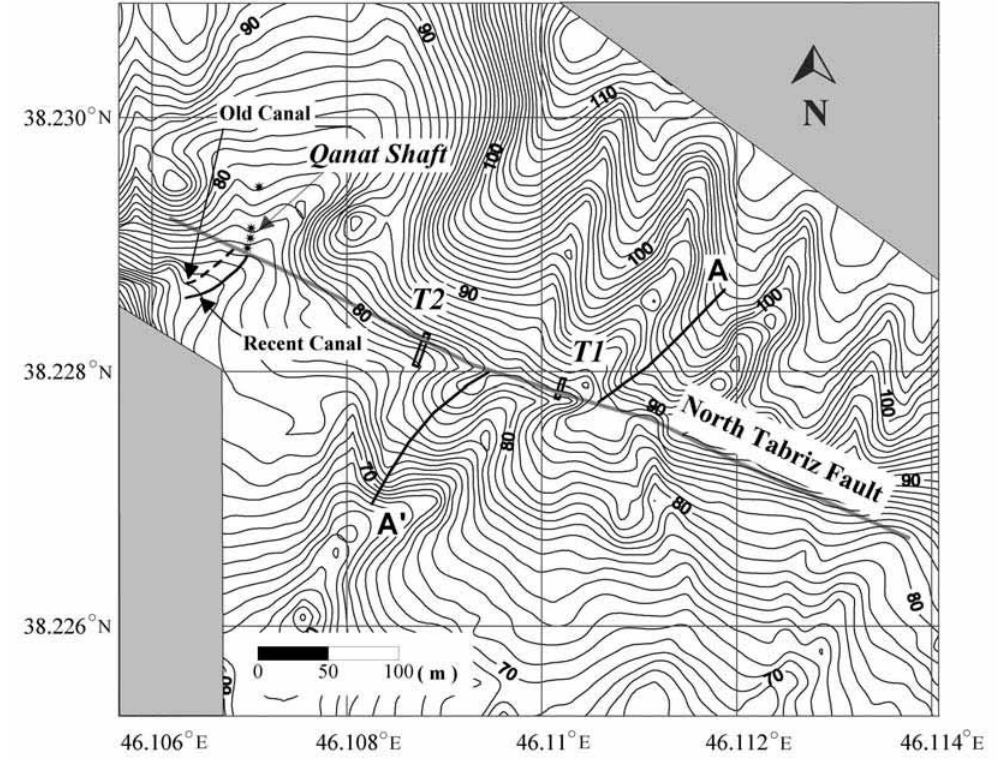
Fig. 6. Large scale topography map (1 m contour line) of the study area and location of trenches (T1 and T2) based on 1075 measured points using Total Station equipment. Displacement of Qanat shaft can be seen on either side of the fault trace. A-A (cid:118)(cid:118) shows location of topographic profile in fig. 5. Double lines show trench